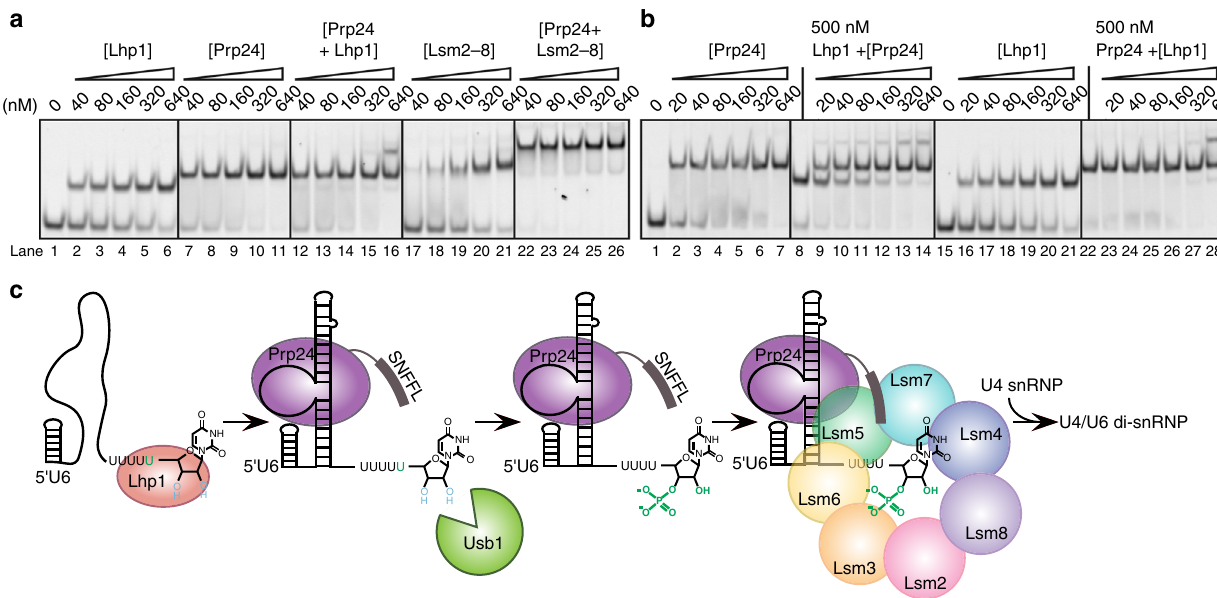
Fig. 6 The U6 snRNP assembly pathway. a Native gel analysis of U6 binding partners. Lhp1 and Prp24 bind U6 1 – 112 with a cis -diol tightly (lanes 2 – 6 and 7 – 11). Inclusion of equimolar amounts of Lhp1 and Prp24 does not promote formation of a ternary complex except at the highest concentration (lanes 12 – 16). In contrast, Lsm2 – 8 binds U6 relatively weakly (17 – 21), but upon inclusion of Prp24 (lanes 22 – 26), Lsm2 – 8 ef fi ciently forms a co-complex of U6, Lsm2 – 8 and Prp24. b Prp24 binds naked U6 1 – 112 with a cis -diol (lanes 2 – 7) and U6 pre-saturated withLhp1 (lanes 9 – 14) tightly. Prp24 abstracts U6 from U6-Lhp1 much more ef fi ciently than it forms a U6/Prp24/Lhp1 complex. Lhp1 binds naked U6 (lane 21), but cannot bind or release U6 from pre-formed U6-Prp24. c Model of U6 snRNP assembly. U6 is synthesized by RNA polymerase III and initially bound by Lhp1. Binding of Prp24